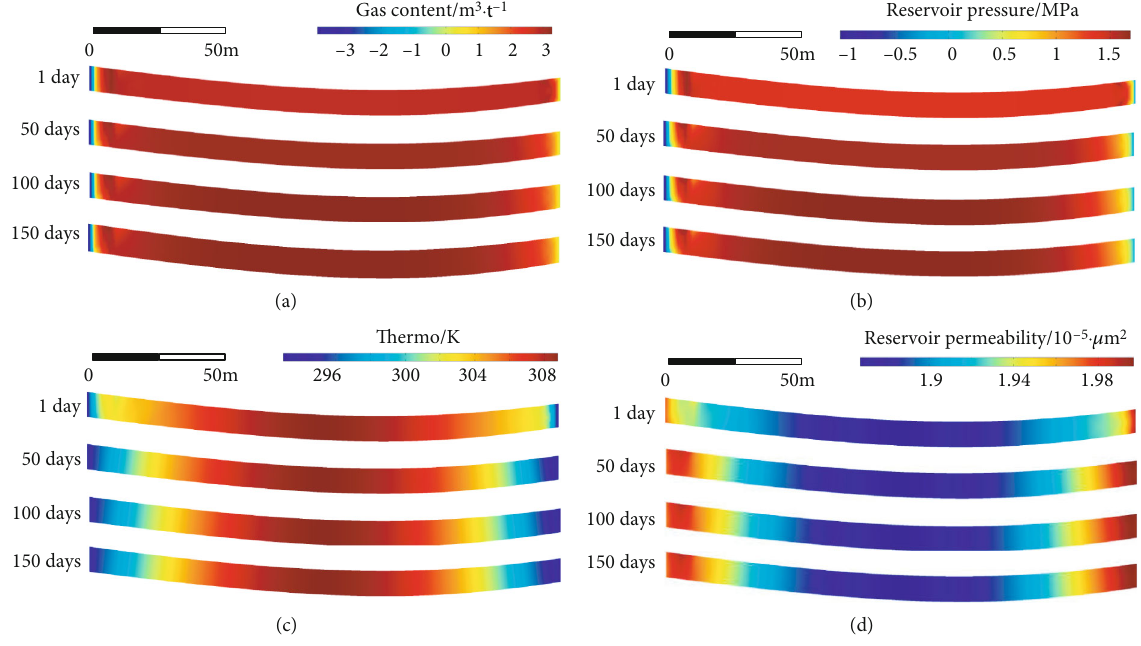
Figure 7: Multi fi eld evolutionary characteristics of THM near the X3 syncline